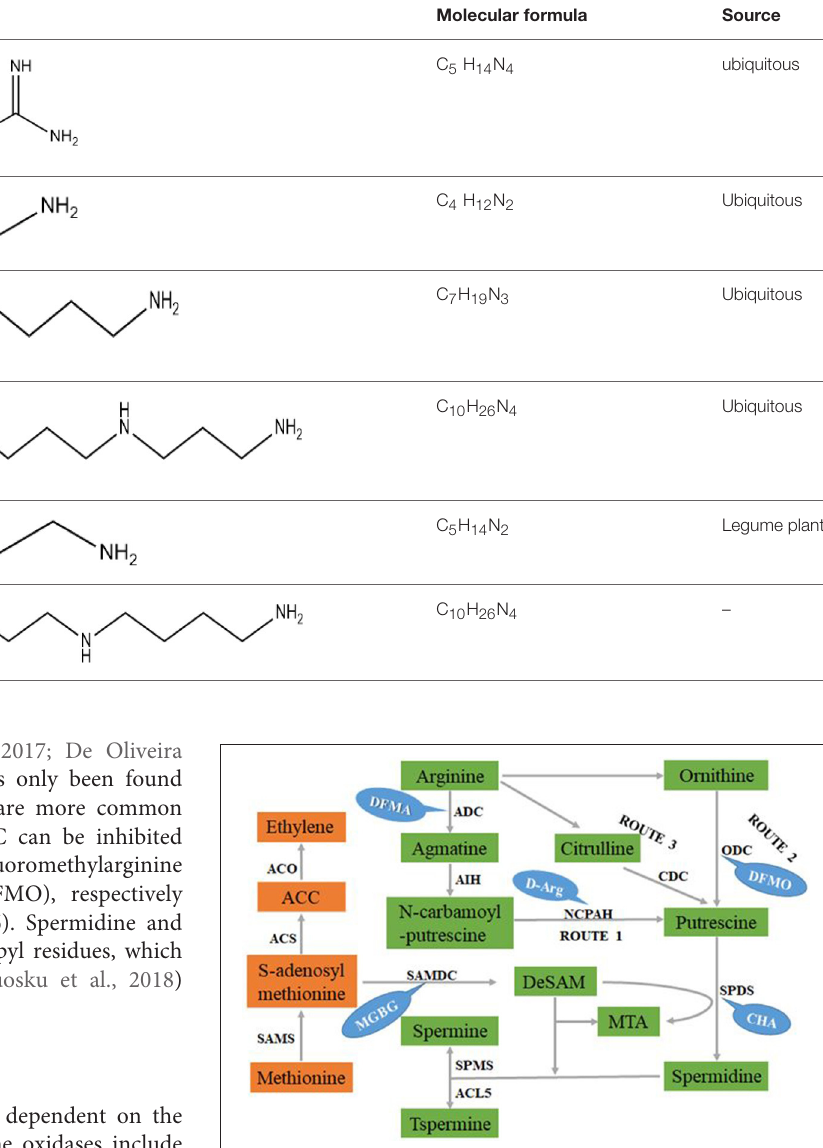
production of metabolic end-products of PAs; for example, the wheat PAO oxidizes Spd and Spm to form 4-aminobutanal,3- aminopropyl-4-aminobutanal,1,3-diaminopropane (Dap) and H 2 O 2 (Cona et al., 2006; Liu et al., 2014). Some PAOs catalyze the reverse reaction of PA synthesis in the PA back-conversion pathway (PBCP) (Liu et al., 2014; Takahashi et al., 2017a). Del Duca and Tassoni et al. found that exogenous Spd applied to Helianthus tuberosis and A. thaliana was transformed into Put (Tassoni et al., 2000). In Arabidopsis , PAO1 and PAO4